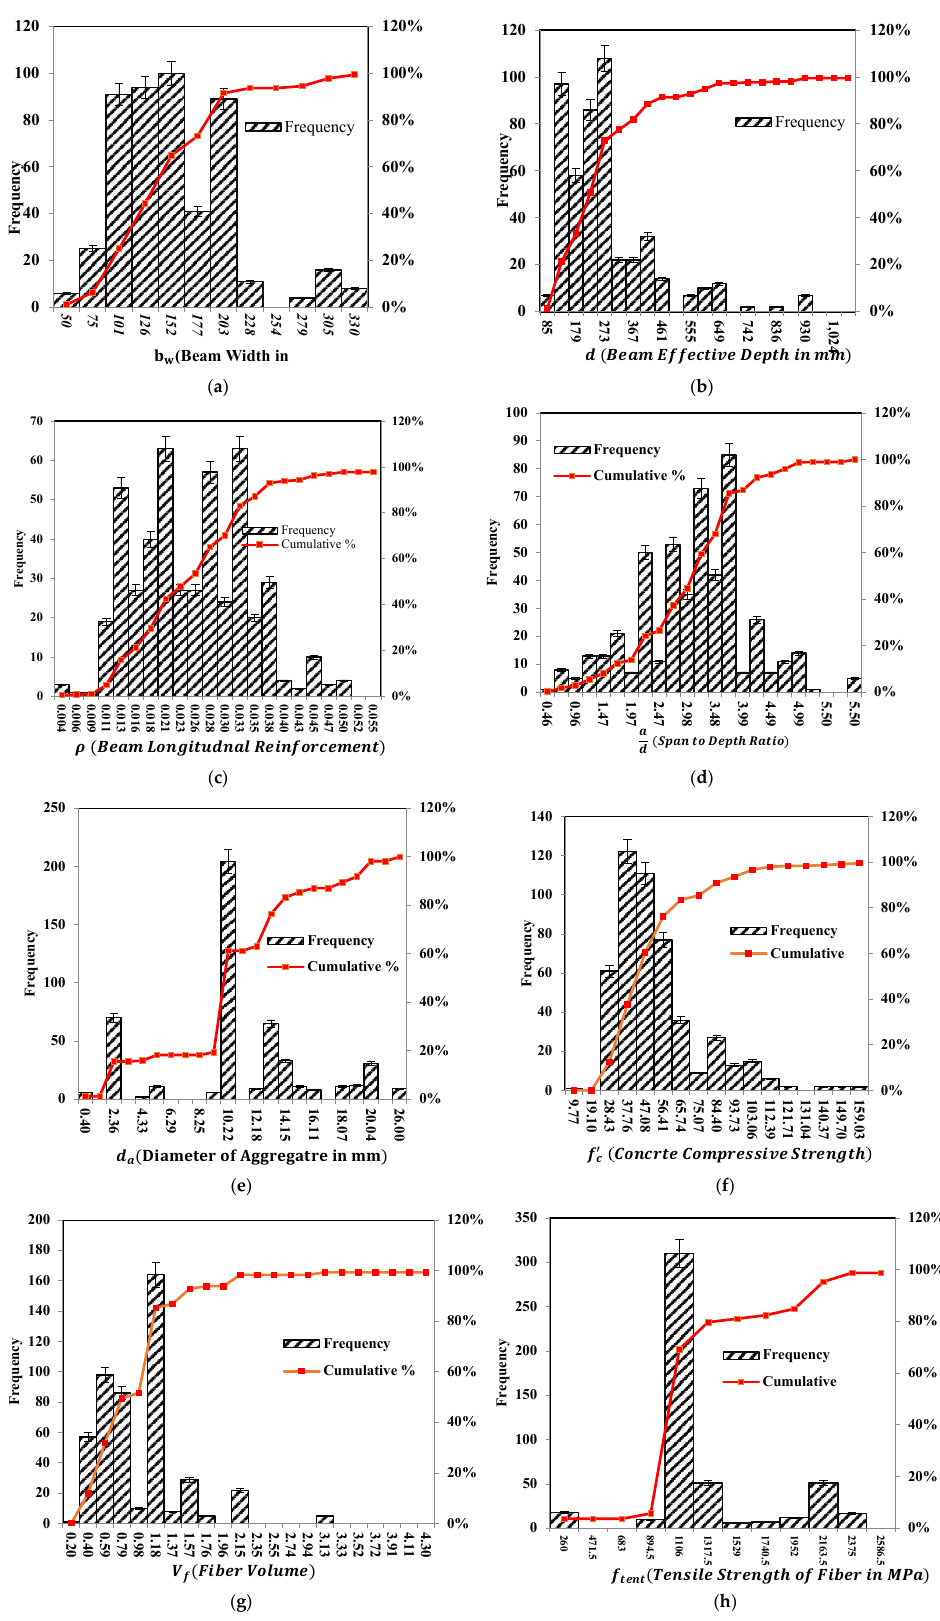
Figure A1. Range of different parameters in dataset: ( a ) Width of beam, ( b ) Effective depth of beam, ( c ) Reinforcement Ratio, ( d ) Length to span ratio, ( e ) Diameter of aggregate, ( f ) Concrete strength, ( g ) Fiber volume fraction, ( h ) Fiber tensile strength.